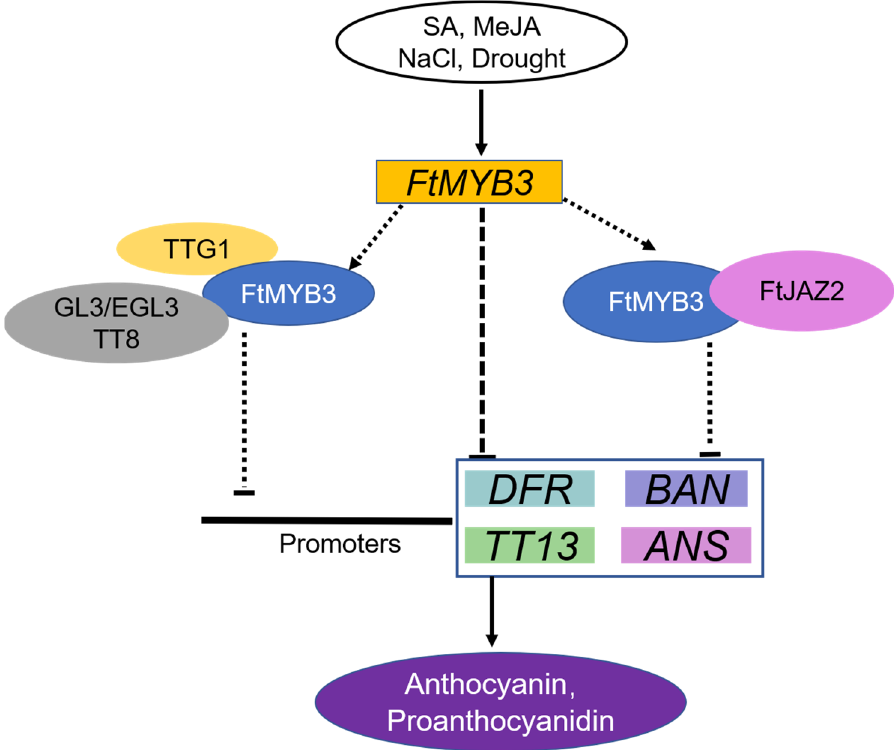
Figure 8. A proposed model depicting FtMYB3 regulation of anthocyanin and PA synthesis under different stresses. FtMYB3 is induced by SA, MeJA, NaCl and drought stress. FtMYB3 directly interacts with TT8, GL3, EGL3, and TTG1 and suppresses their transcriptional activator of DFR , ANS , BAN and TT13 . Additionally, FtMYB3 may inhibit the synthesis of anthocyanins/PAs by interacting with FtJAZ2 protein.